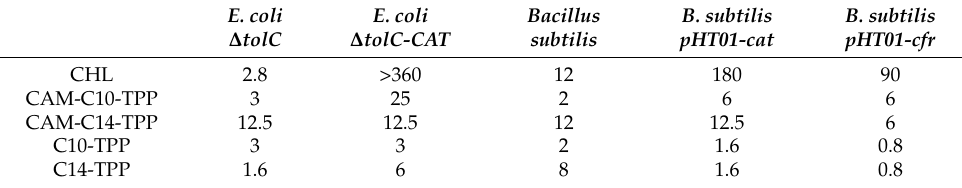
Table 2. Suppression of the growth of E. coli strains, with the deletion of the tolC gene and the harboring CHL acetyltransferase ( cat ) gene ( E.coli ∆ tolC-CAT ) or B. subtilis CHL-resistant strains ( B. subtilis pHT01-cat ) and the harboring methyltransferase Cfr (cfr) gene ( B. subtilis pHT01-cfr ) by CAM-Cn-TPPs. The values of a minimal inhibitory concentration (MIC, µ M) are shown 1 . E. coli E. coli Bacillus ∆ tolC ∆ tolC-CAT subtilis